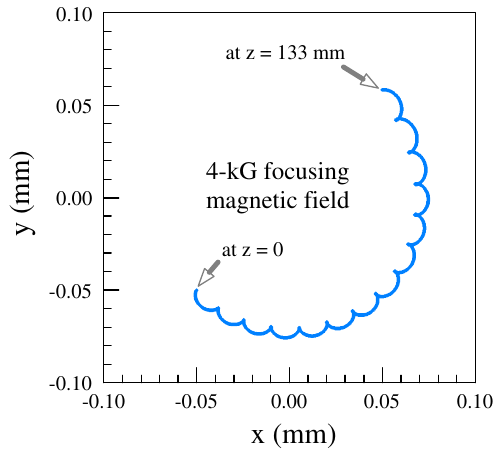
FIG. 17. (Color) Orbit projected on the x - y plane ( 0 (cid:14) z (cid:14) 133 mm ) for a sample electron at the beam edge. Note that the electron gyrates clockwise around the focusing magnetic while the guiding center drifts along the E (cid:5) sc (cid:6) (cid:10) B field B 0